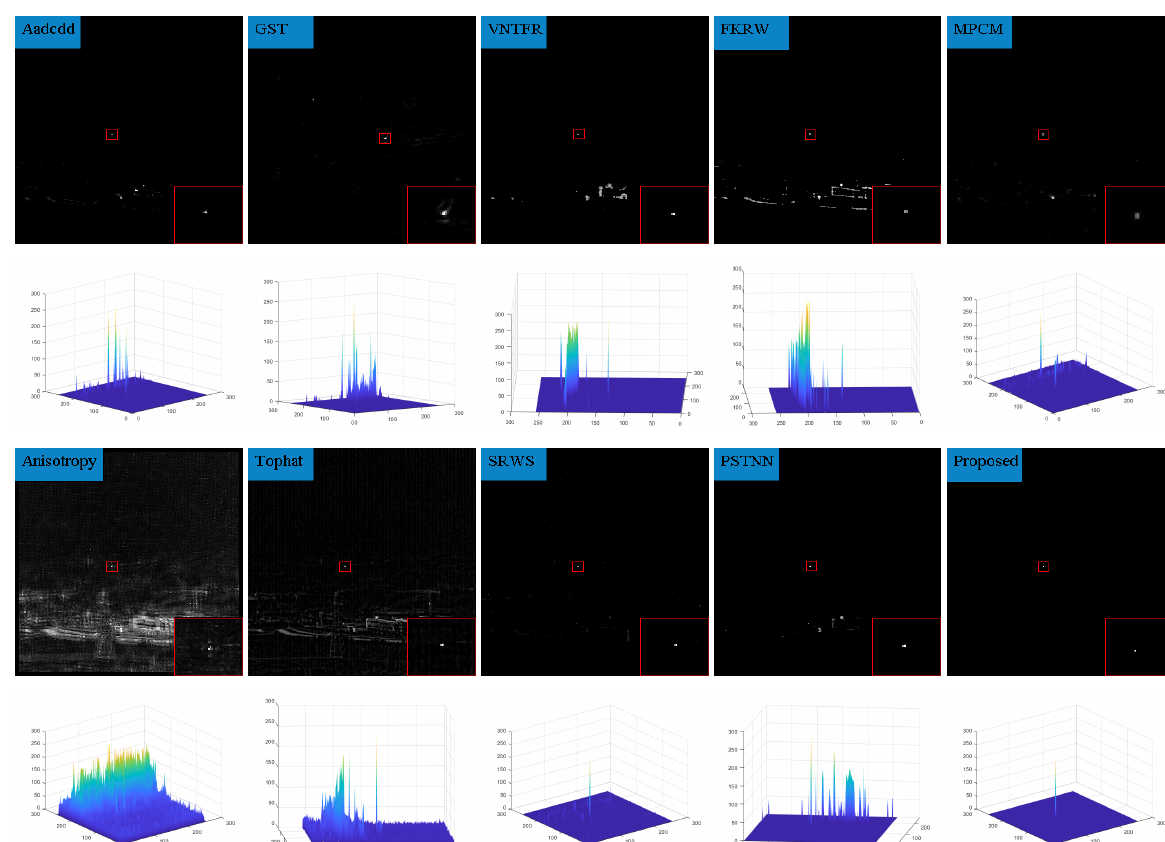
Figure 11. Detection results of sequence